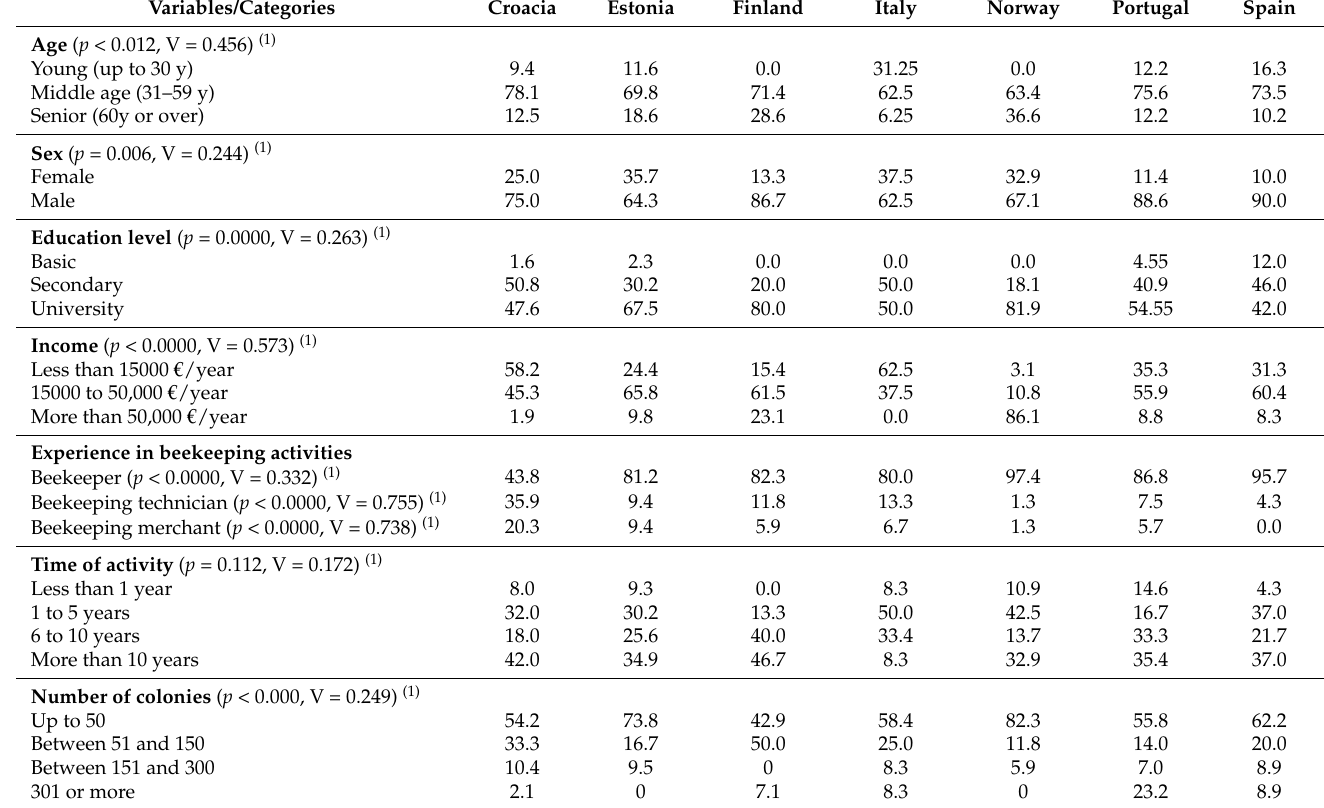
Table 4. Crosstabs and Chi-square tests among countries and some sociodemographic variables and variables associated with beekeeping activities. Percentages of positive answers for each